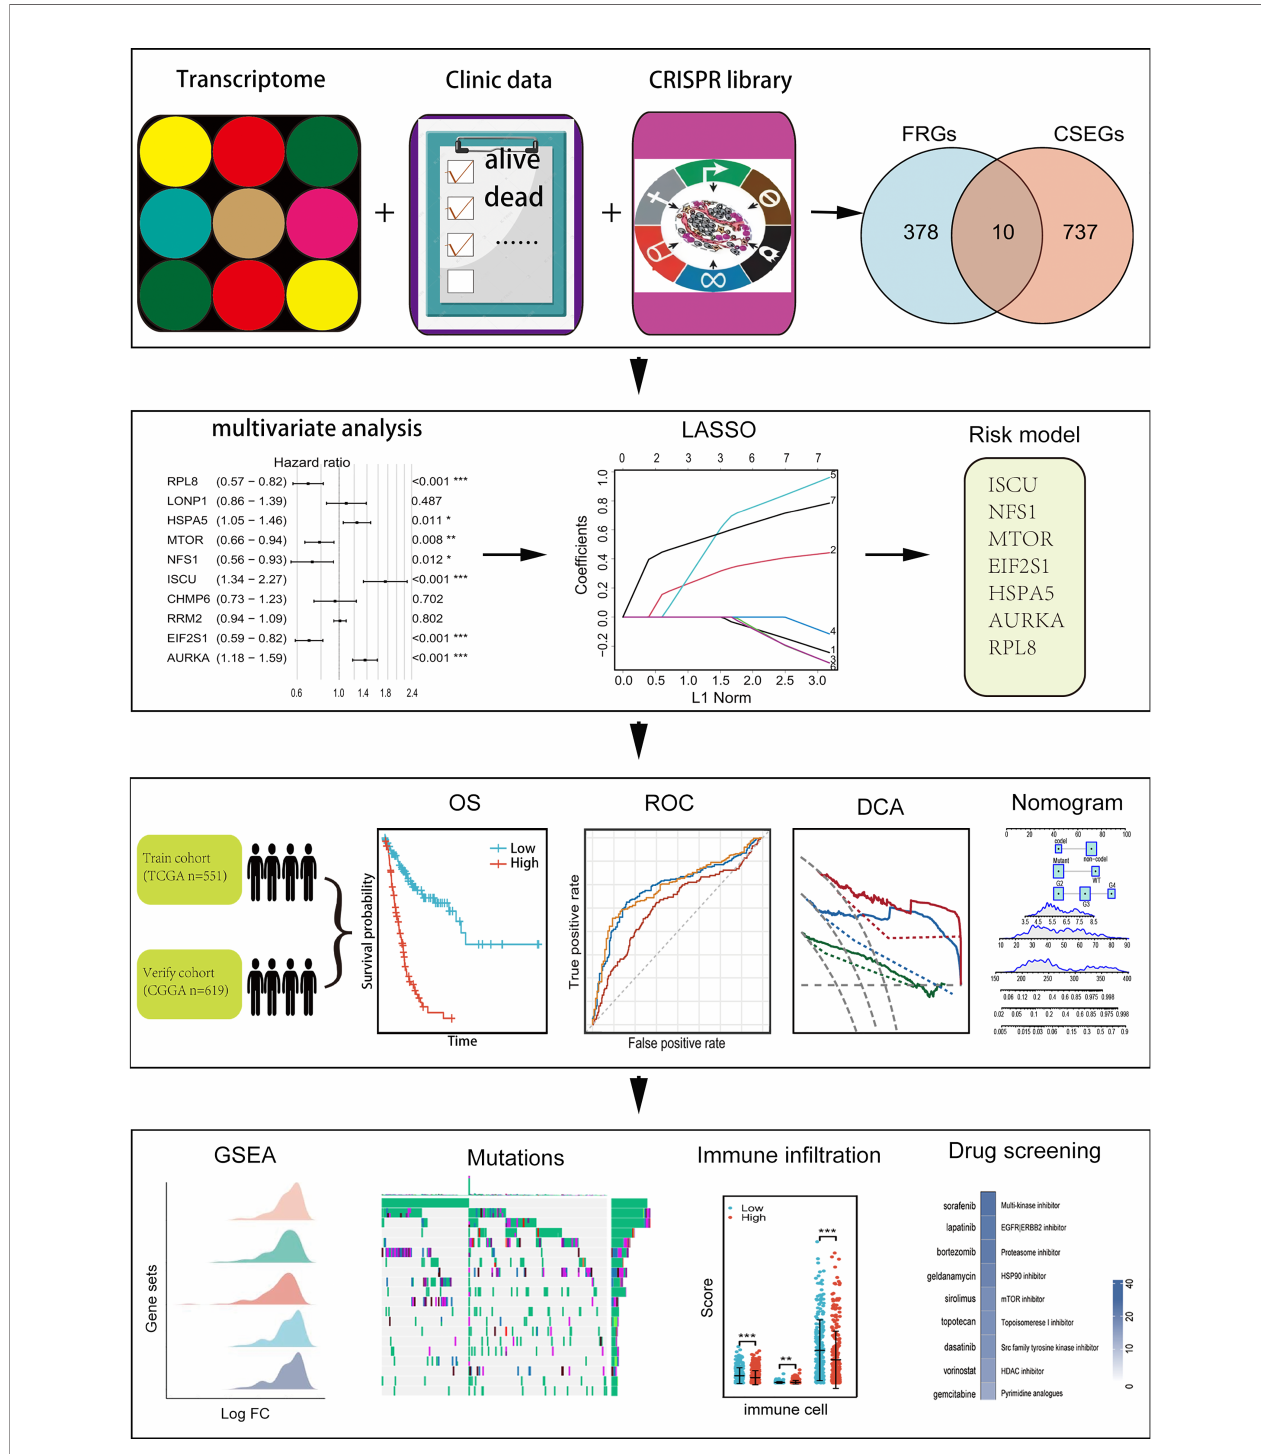
FIGURE 1 | Flow chart showing the design of the